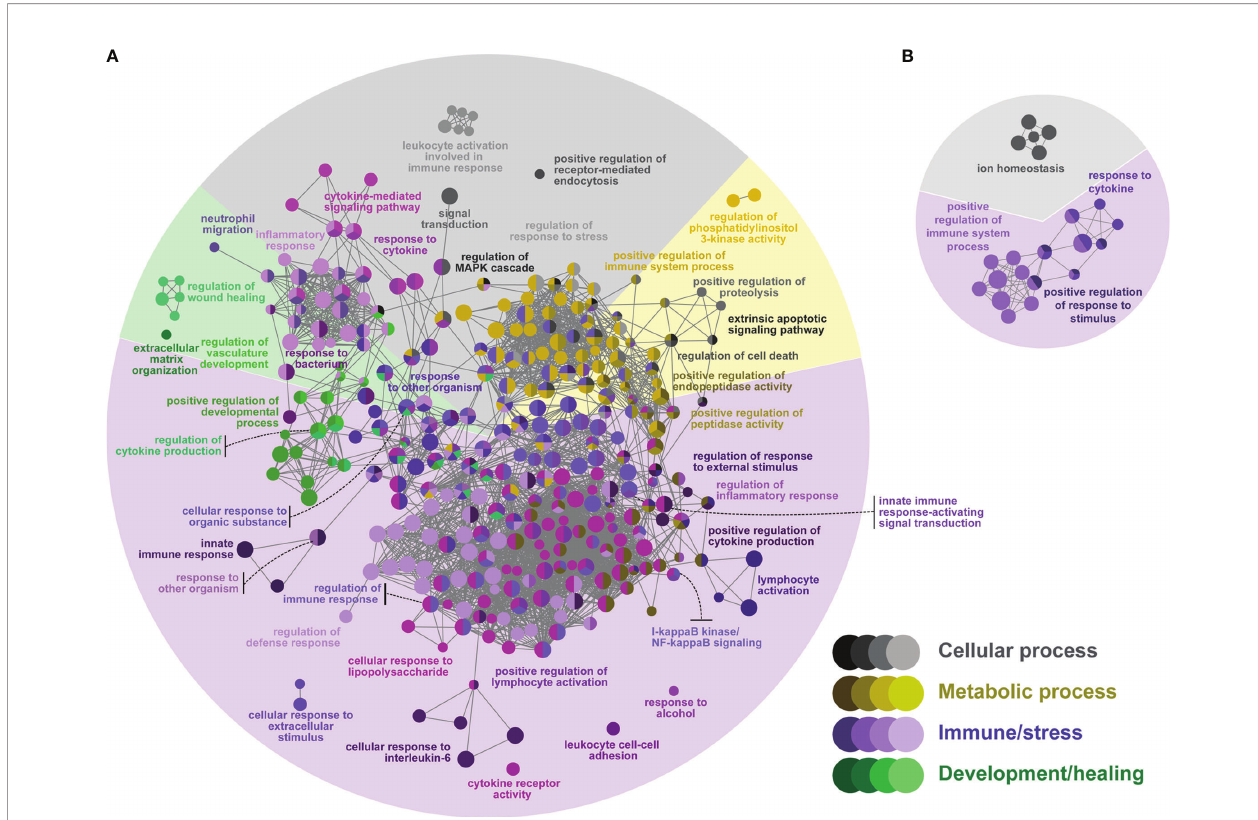
FIGURE 4 | Network GO term enrichment analysis of the differentially expressed genes (DEGs) in (A) the ASAL(lice) list, and (B) the ASAL(no lice) list. Nodes represent over-represented GO terms (right-sided hypergeometric test; adjusted p-value < 0.05). Nodes are colored according to their assigned functional theme. Highly related terms (kappa coef fi cient > 0.4) are connected with grey lines. Single GO terms (i.e., single node) and GO networks are grouped and colored by functional theme (e.g., metabolic process, immune/stress) and arranged to fi t the pie chart sectors representing the proportion of GO terms in each functional theme. Some GO groups comprised terms from different themes; in such cases, the group is colored according to the theme with the highest number of GO